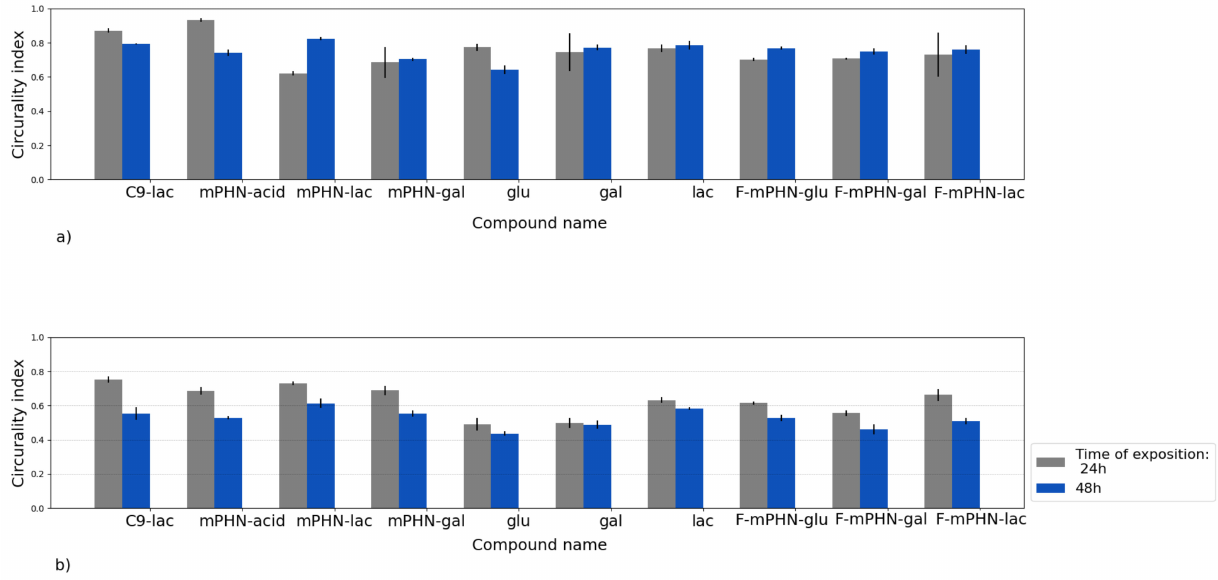
Figure 3. Changes of nuclei roundness based on image analysis algorithms. These small changes may indicate some reorganizations of cytoskeleton but are not typical for metastatic transition: ( a ) DU145; ( b )